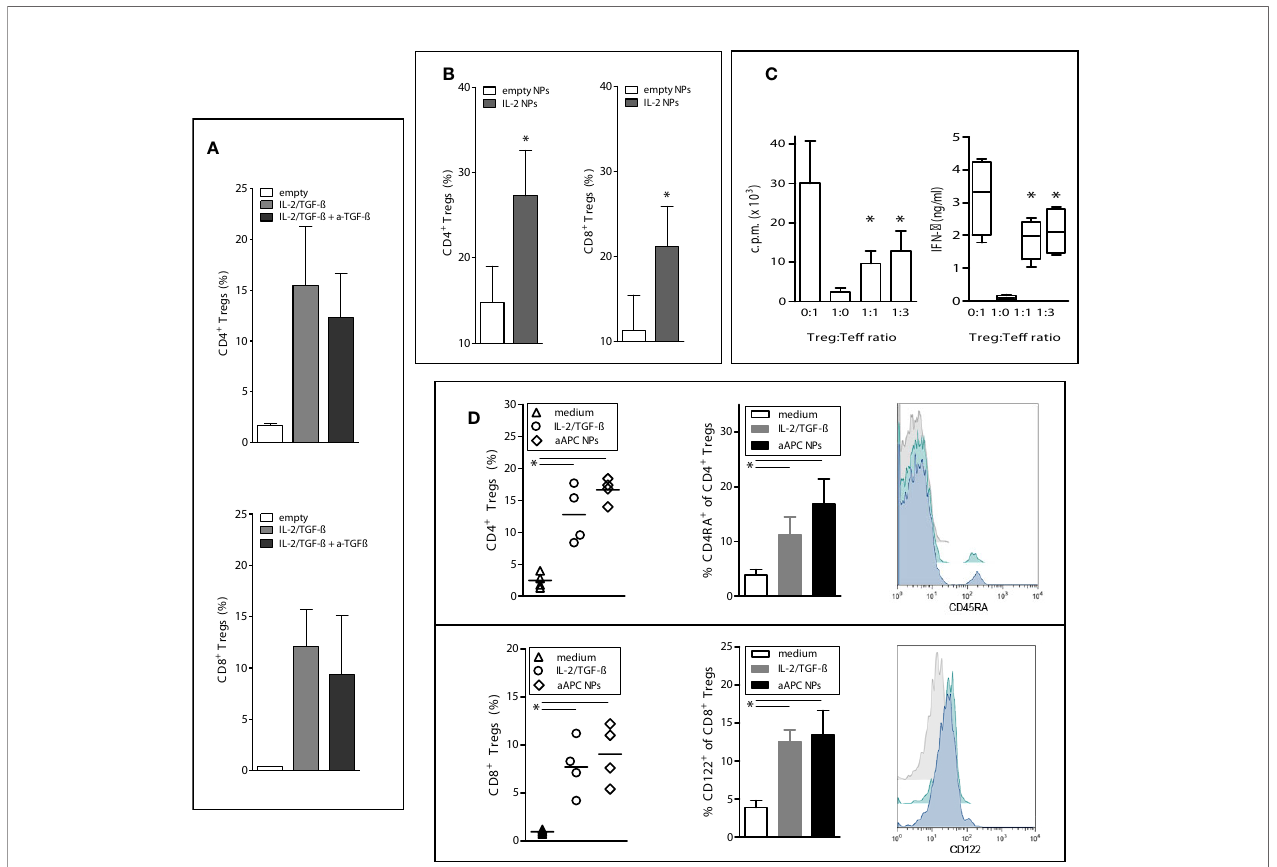
FIGURE 2 | Paracrine delivery of cytokines by aAPC NPs to human T cells favors the induction and expansion of functional Tregs in vitro . To induce Tregs, human PBMCs from healthy donors (n = 6) were cultured with IL-2/TGF- b -loaded NPs targeted to T cells (decorated with anti-CD3/28) for 5 days. To study the expansion of the induced Tregs, the cultured cells were then washed twice before incubation with IL-2-encapsulating NPs or empty NPs for 5 more days with or without anti-TGF- b antibody (10 µg/ml). (A) The expansion of aAPC NP-induced CD4 + and CD8 + Tregs is not in fl uenced signi fi cantly by the blockade of TGF- b . P not signi fi cant in the presence or absence of anti-TGF- b . (B) T-cell-targeted NPs that only encapsulate IL-2 promote the expansion of CD4 + and CD8 + Tregs; *P < 0.05 by the Student ’ s t test. (C) CD4 + Tregs induced by aAPC NPs targeted to T cells suppress in vitro the proliferation (left) and IFN- g production (right) of cocultured CD4 + CD25 - T cells. *P < 0.05 in the comparison with Treg : Teff at the 0:1 ratio (only stimulated T effector cells). (D) Comparison of induction of CD4 + (top) and CD8 + (bottom) Tregs by aAPC NPs decorated with anti-CD3/28 vs. anti-CD3/28 beads in the presence of soluble IL-2/TGF- b . Control cultures had medium only. Percentage numbers and representative histograms (grey, medium only; green, IL-2/TGF- b ; blue, aAPC NPs) for the expression of CD45RA by CD4 + Tregs and CD122 by CD8 + Tregs (n = 4 donors). *P < 0.05 by the Student ’ s t test in the comparison vs. medium only; not signi fi cant between cultures with IL-2/TGF- b and aAPC